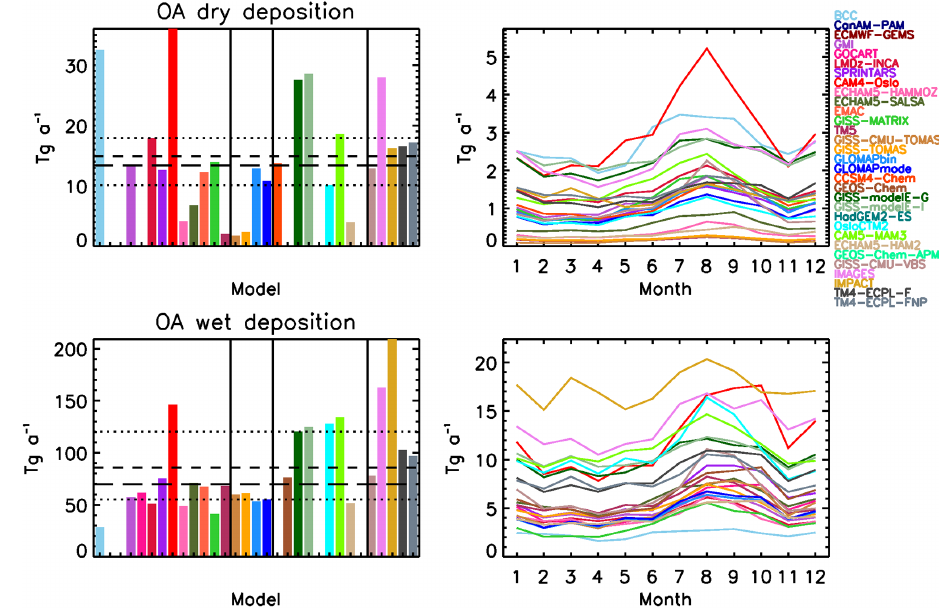
Figure 4. Same as in Fig. 2, for the dry/wet OA